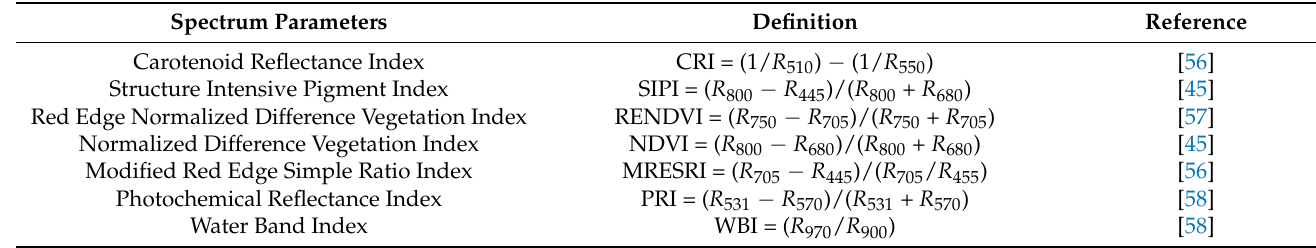
Table 1. Optimization of spectral parameters and calculation